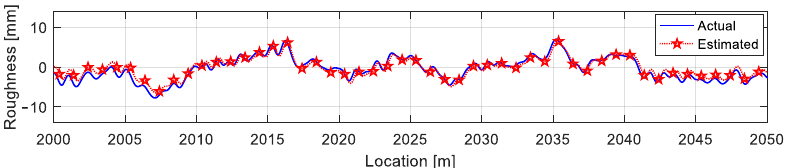
Figure 25. Time histories of the estimated roughness of the road surface among 2000~2050 m.